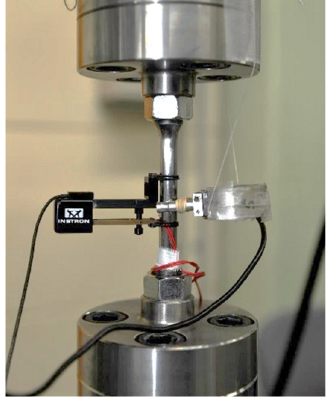
Figure 3. Detail of the equipment for measuring the strain and the specimen diameter.